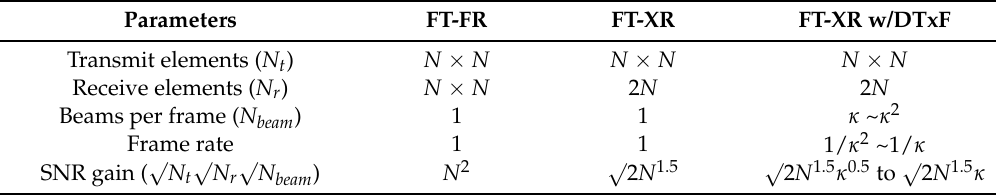
Table 1. Quantitative summary of FT-FR and FT-XR for N × N element array.